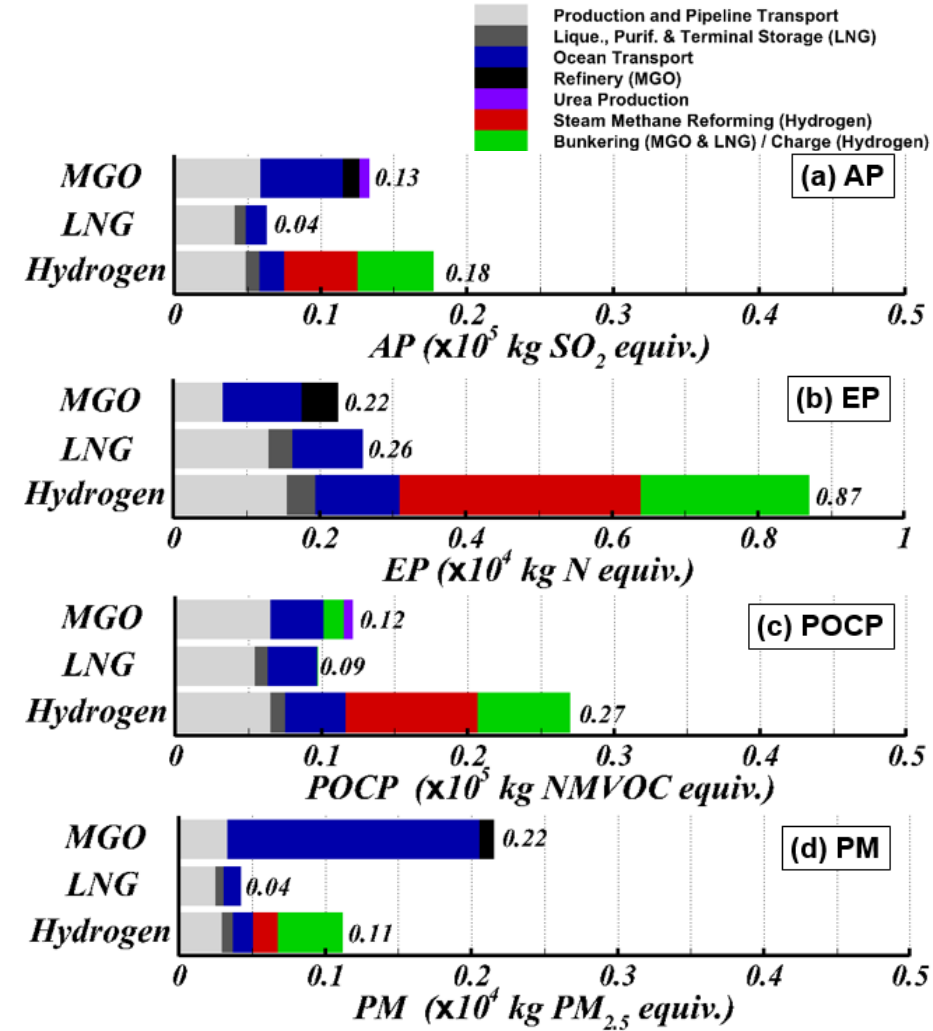
Figure 15. ( a ) AP, ( b ) EP, ( c ) POCP, and ( d ) PM results in the well-to-tank phase. Figure 15. AP, EP, POCP, and PM results in the well-to-tank